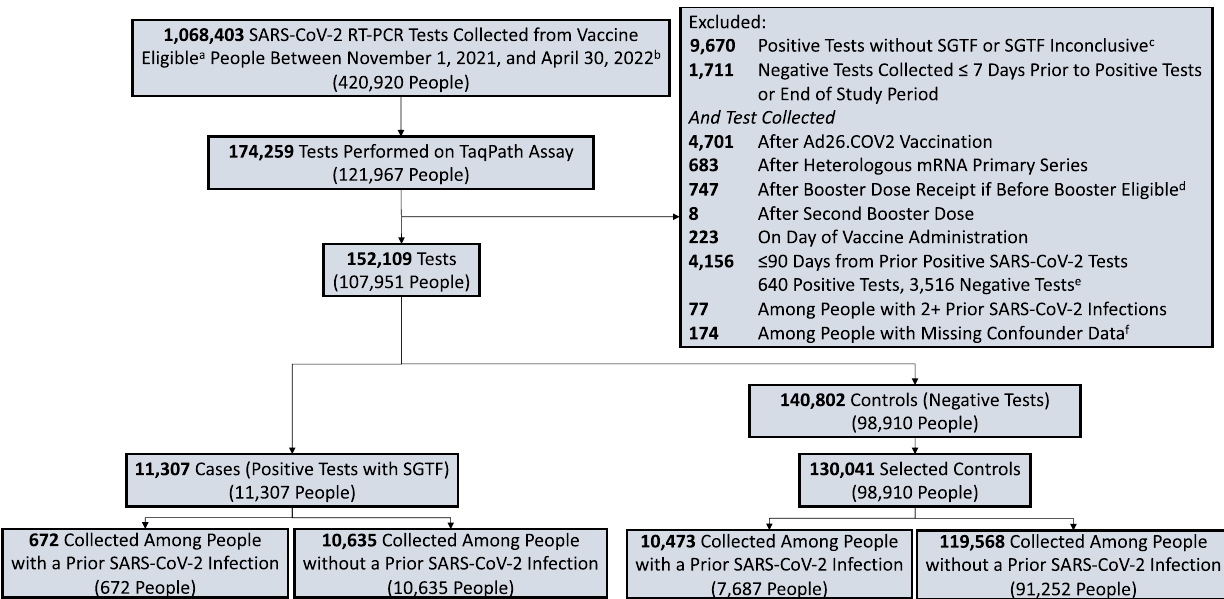
Fig 2. Selection of tests for the case–control analysis. The sample was limited to RT-PCRs run on the TaqPath COVID-19 (Thermo Fisher Scientific) assay among vaccine-eligible individuals. Case status was defined based on the reflex results. We included all positive tests (cases) and up to three negative tests (controls) per person. Cases and controls were stratified by presence of a documented prior infection (a positive RT-PCR or rapid antigen test at least 90 days before the included test). a Vaccine eligibility was defined as age � 5 years. b The first SGTF defined Omicron (BA.1 lineage) variant infection in the study population was identified on November 11, 2021. c Samples with a positive reflex RT-PCR but that did not meet our SGTF definition (an ORF1ab Ct value of < 30 and S-gene Ct–ORF1ab Ct value � 5; or 2] ORF1ab Ct value < 30 and S-gene Ct value � 40. d Excluded tests that were performed after a person was given a booster dose before FDA authorization or that was given less than 150 days after primary vaccination completion. e The median time between the 640 dropped positives and the prior positive was 5 days (first-third quartiles: 3 to 7 days). f There were 134 people with missing SVI data, 40 people with missing sex data and none with missing age data. People were allowed to contribute up to three negative tests to the control sample. If they had more than three negative tests over the study period, three tests were randomly selected. If a person had more than one negative test within a 7-day period, one test performed within that period was randomly selected. COVID-19, Coronavirus Disease 2019; RT-PCR, reverse transcription PCR; SGTF, S-gene target failure.